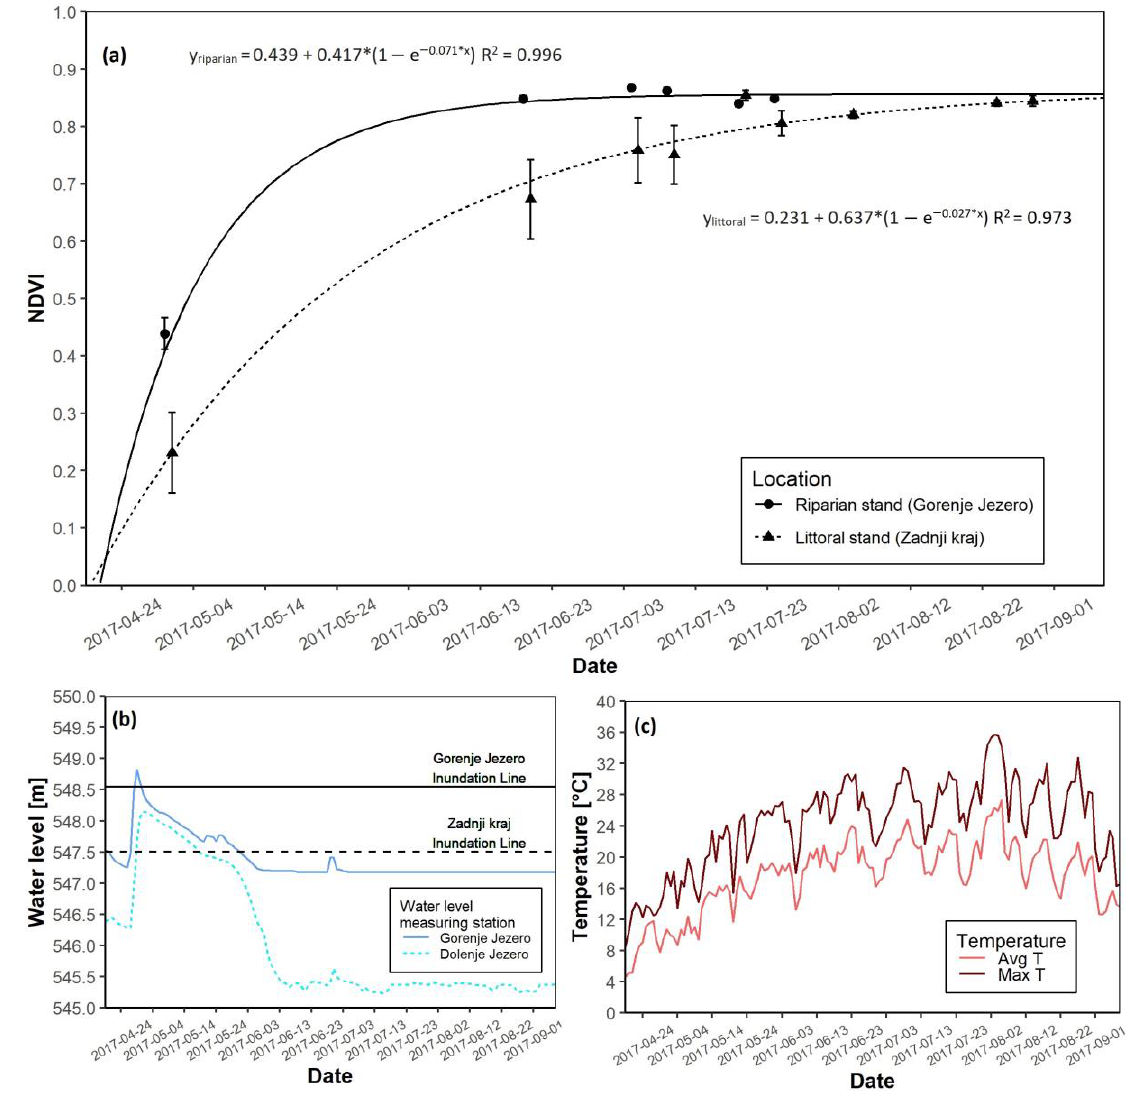
Figure 4. NDVI growth models for both reed sites with water level data for the 2017 growing season. ( a ) NDVI growth models for the riparian and littoral reed stands; ( b ) Water level data for the riparian and littoral reed stands; ( c ) Daily average and maximal temperatures.